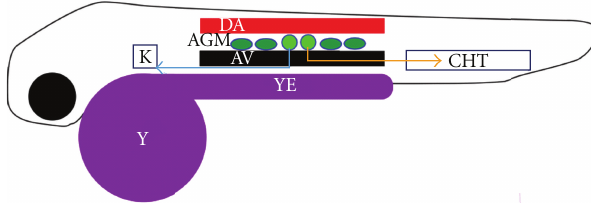
Figure 4: Schematic representation of thrombocyte development in zebrafish larva. DA, dorsal aorta; AV, axial vein; AGM, area corre- sponding to mammalian aorta- gonad- mesonephros; CHT, caudal hematopoietic tissue; K, kidney; Y, yolk; YE, yolk extension; filled small circles and ovals represent GFP Low and GFP High thrombocytes, respectively. The yellow and blue lines with arrows correspond to the routes of immigration of the thrombocytes. Thymus is not shown. Black circle and outline show the eye and the zebrafish body,